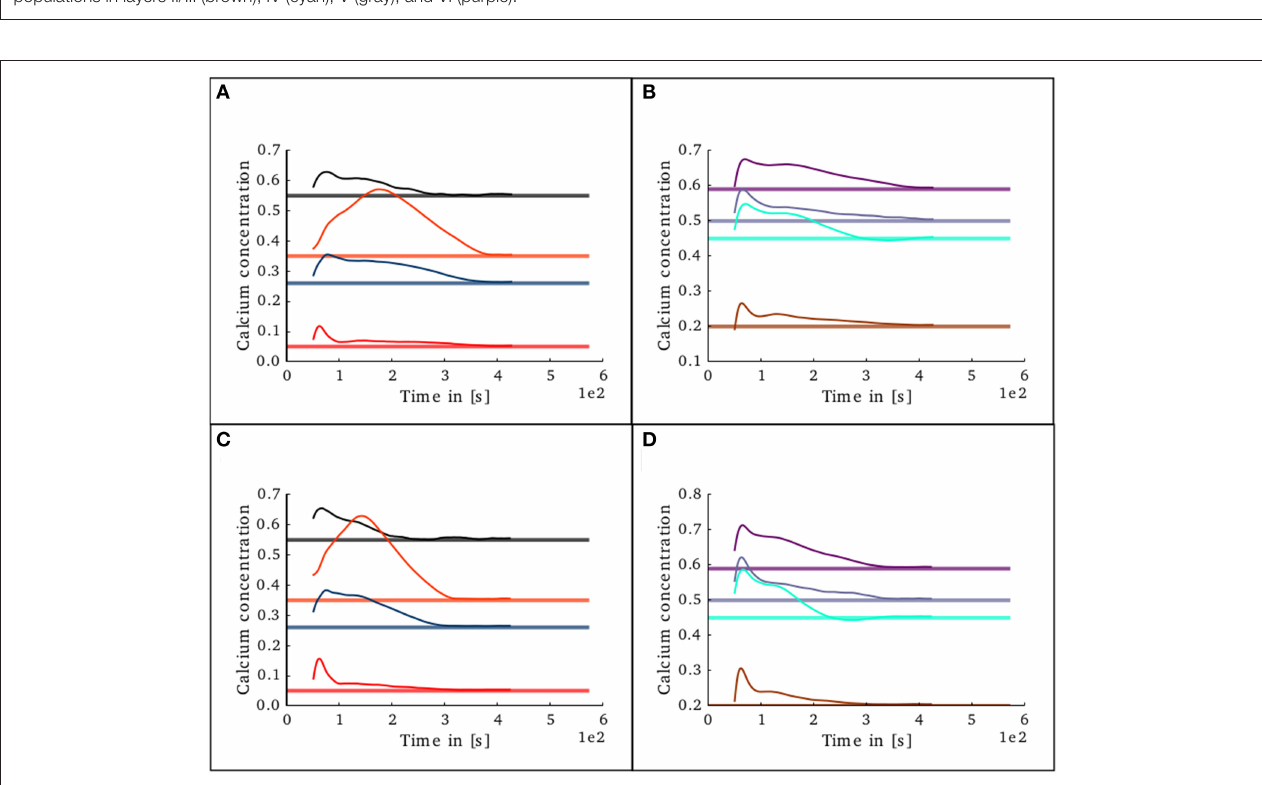
FIGURE 11 | Evolution of calcium concentration in each layer of the cortical microcircuit model with partially pre-connected initial conditions. Pale horizontal lines indicate the target concentration of the corresponding population. Left pannels show excitatory populations in layers II/III (red), IV (blue), V (black), and VI (orange). Right pannels show inhibitory populations in layers II/III (brown), IV (cyan), V (gray), and VI (purple). (A,B) Show the scenario where the network was started with the connectivity as specified in the original work by Potjans and Diesman. (C,D) Show the same scenario but with a 10% error in the initial connectivity